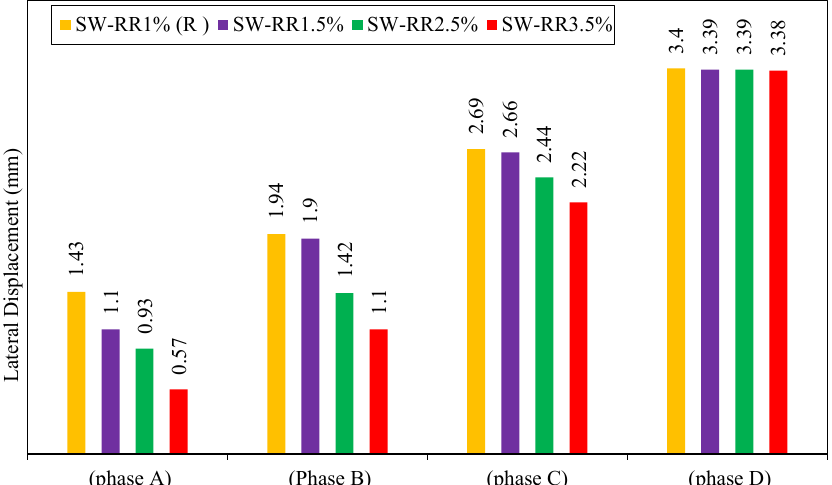
Figure 8. Lateral displacement of group 1.